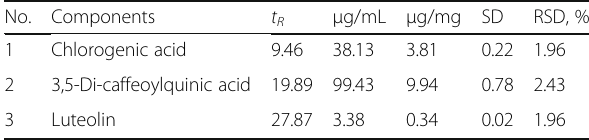
Table 2 The amounts of three analytes in ECZ using HPLC-DAD No.